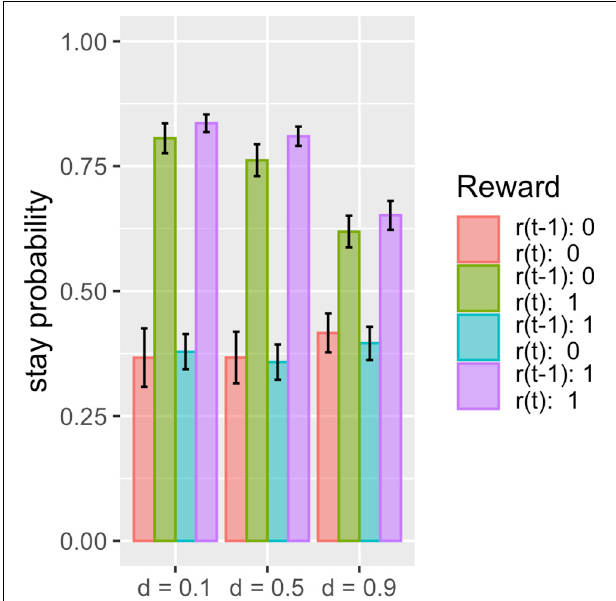
FIGURE 5 | Stay probability and surprise decay rate. Data are presented as the mean ± standard error. We investigated how the surprise decay rate ( d ) affected the stay probability and found that as the parameter increased, the stay probability of proximate reward conditions [ r ( t ) = 1]